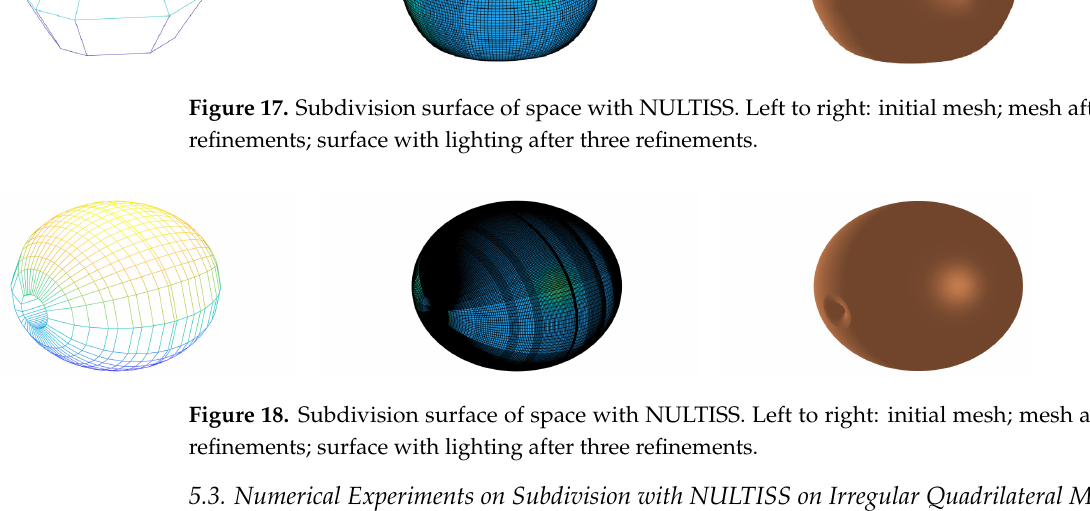
Figure 18. Subdivision surface of space with NULTISS. Left to right: initial mesh; mesh after two refinements; surface with lighting after three refinements.